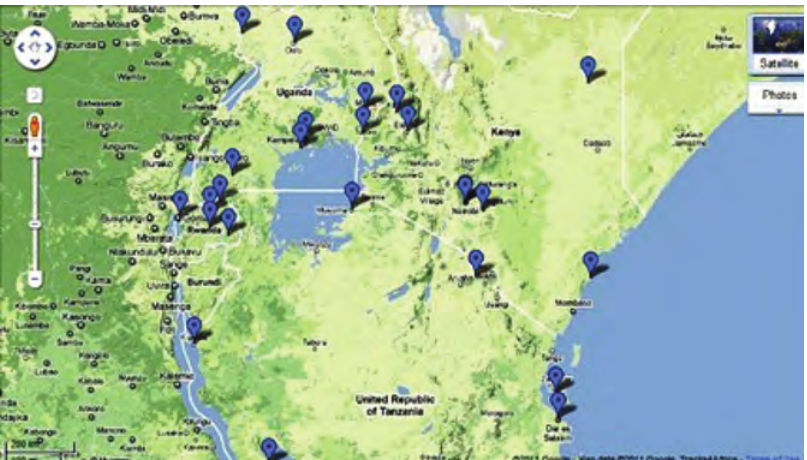
FIGURE 13. Location of Satellite